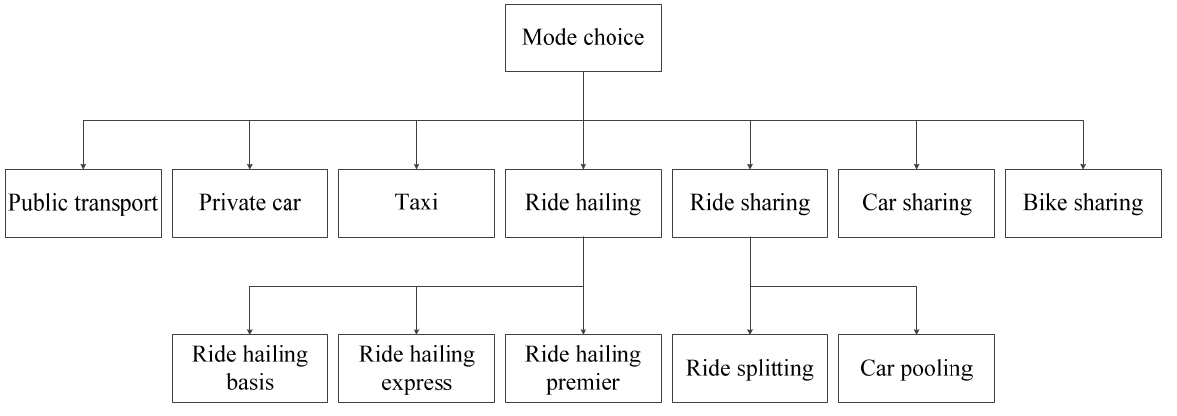
Figure 4. NL model structure.